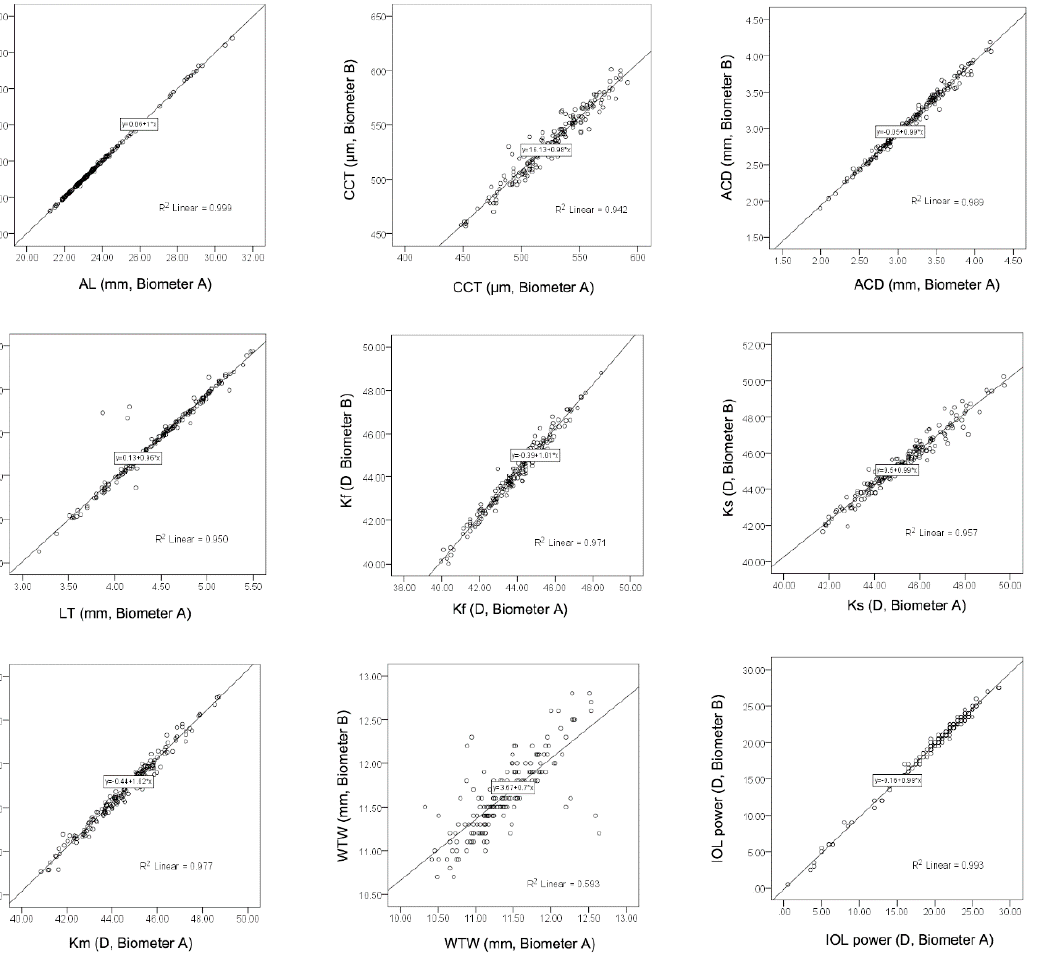
Figure 3. Scatterplots demonstrate the correlation between the axial length (AL), central corneal thickness (CCT), anterior chamber depth (ACD), lens thickness (LT), flat keratometry (Kf), steep keratometry (Ks), mean keratometry (Km), white-to-white (WTW) distance, and intraocular lens (IOL) power measured using biometers A and B. The regression equation between the two biometers is demonstrated in the rectangular box (x represents biometer A; y represents biometer B). Table 2. Anterior segment parameters in both devices.